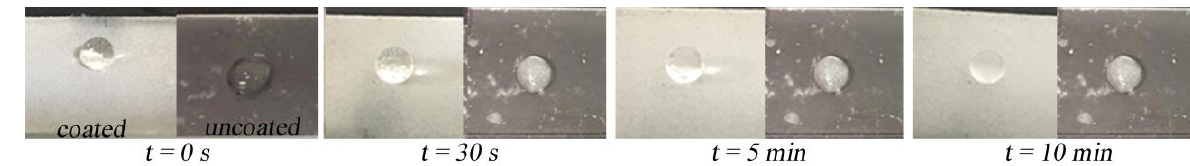
Figure 13. Anti-icing properties of FEP-S coating.